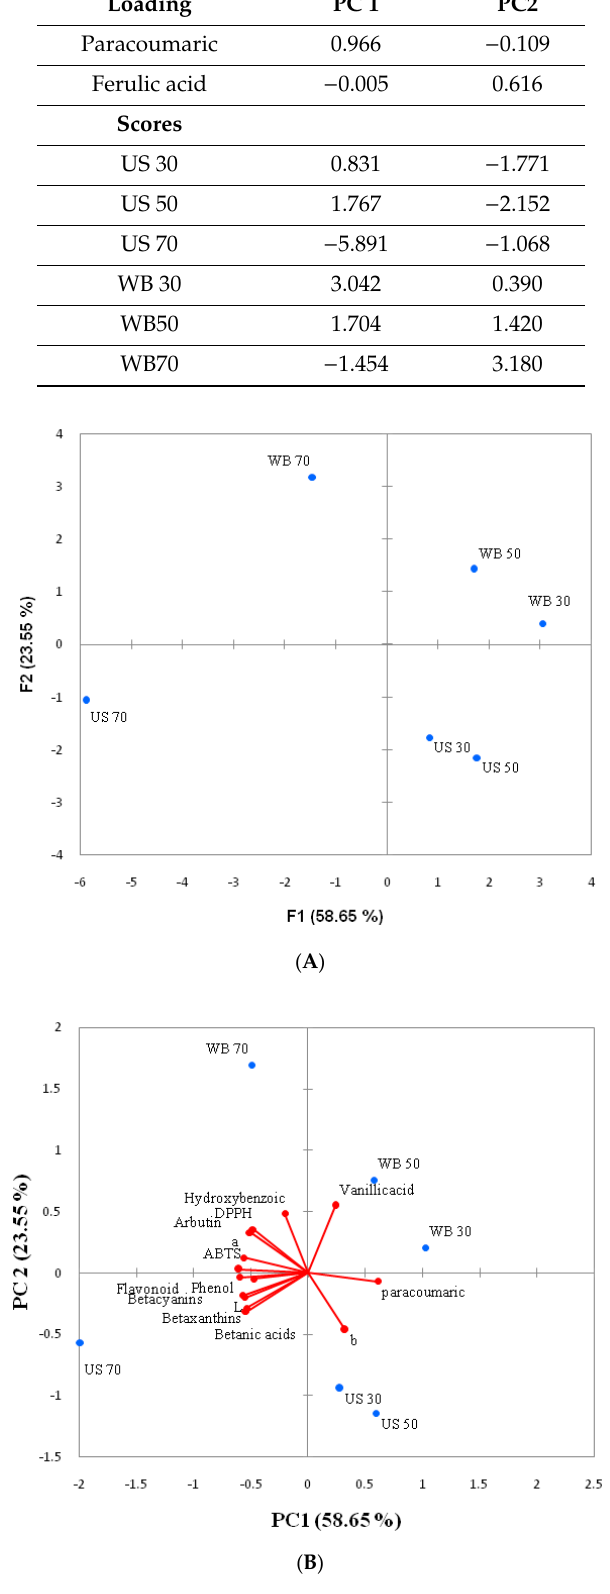
Figure 6. Principal component analysis of amaranth extract. ( A ) Parameter loading; ( B ) sample scores.